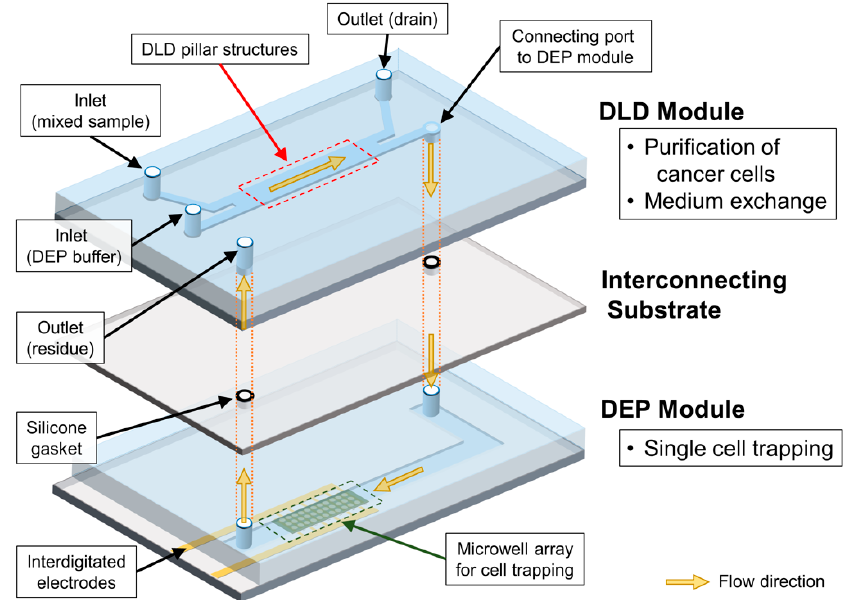
Figure 2. Schematic diagram of overall sequential cell-processing system.